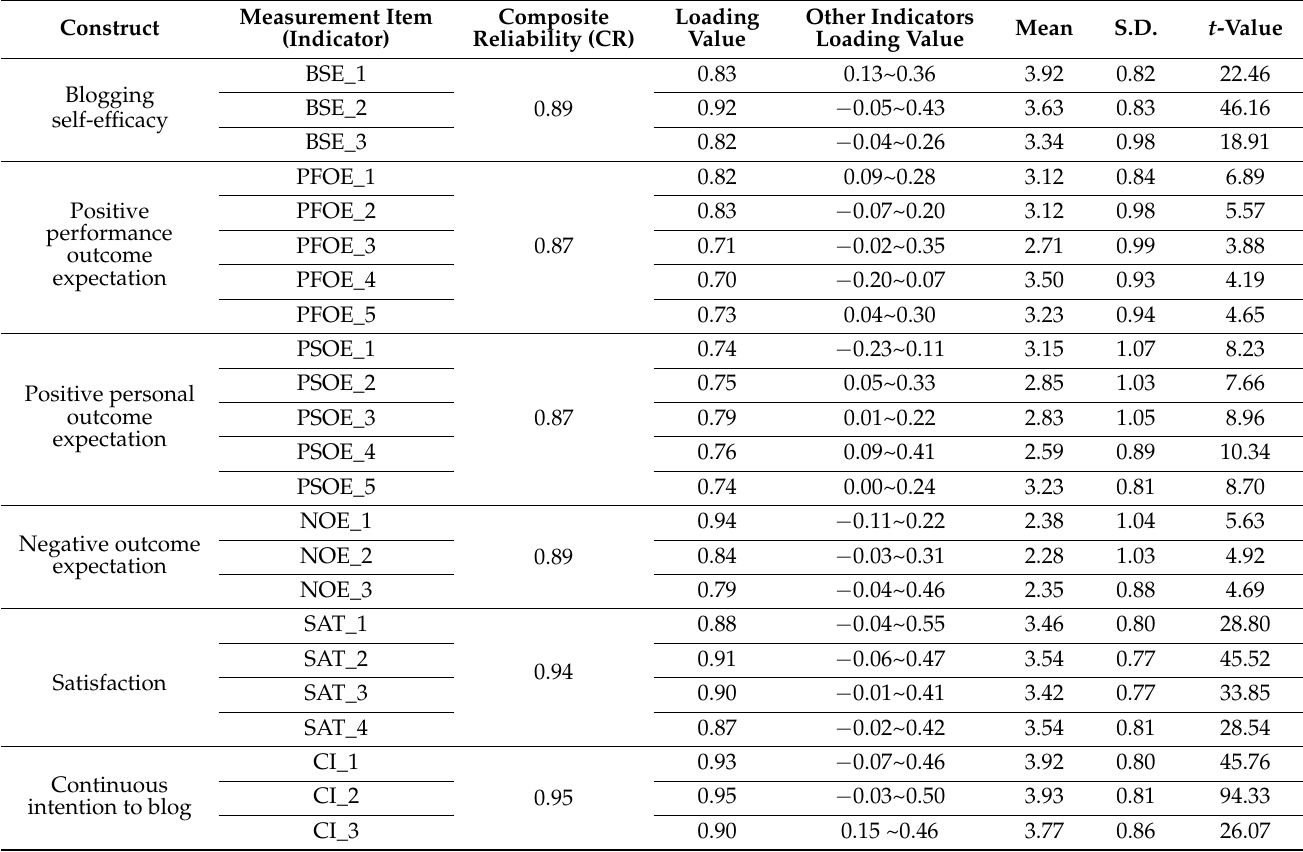
Table 3. The Measurement Properties for